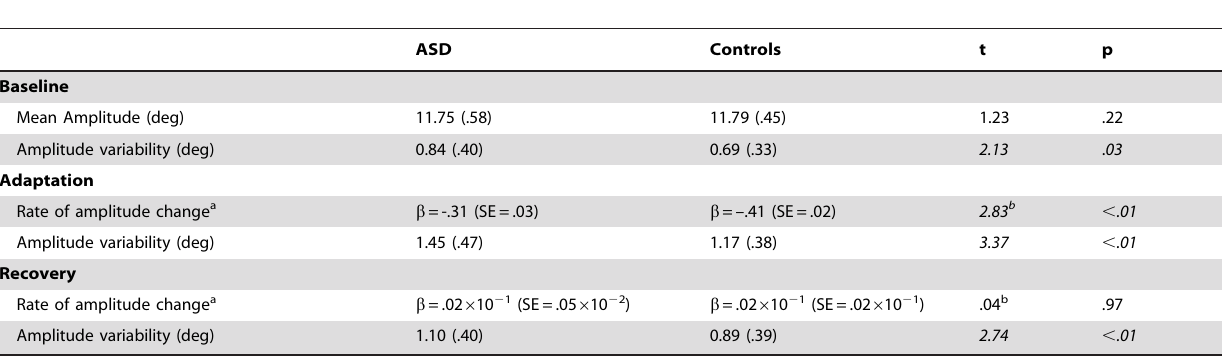
Table 2. Saccade amplitude and amplitude variability on 12 deg trials for individuals with autism spectrum disorders (ASD) and healthy controls during baseline testing, adaptation, and post-adaptation recovery.